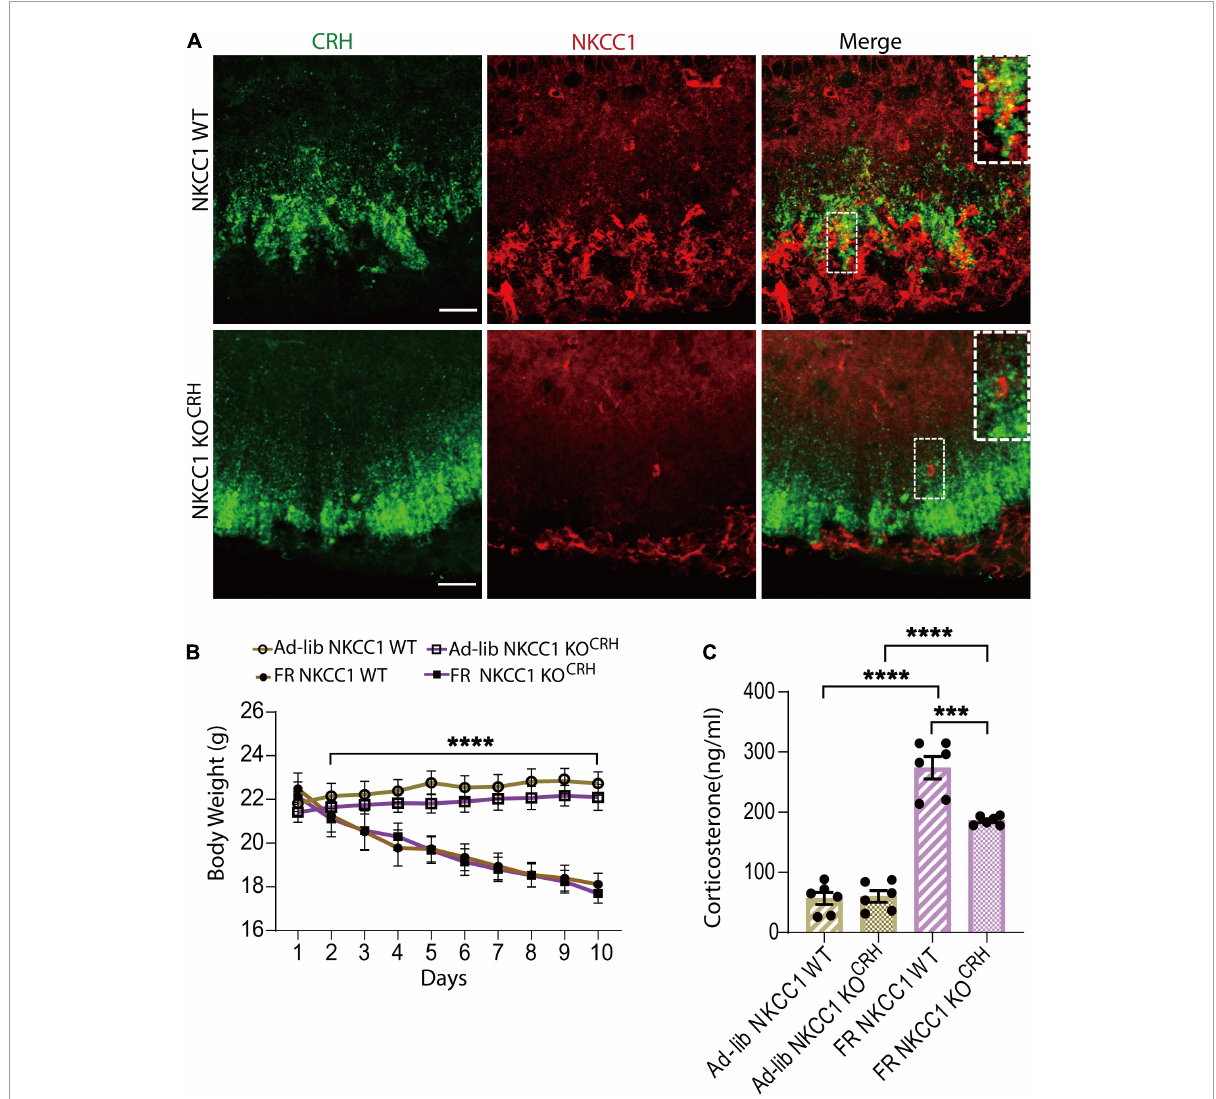
FIGURE5 Conditional deletion of NKCC1 from corticotropin-releasing hormone (CRH) neuronal terminals reduced the elevation of serum corticosterone in response to food restriction. (A) Immunohistochemical staining with anti-CRH (green) and anti-NKCC1 (red) antibodies in CRH neuronal terminals in the median-eminence (ME). NKCC1 immunoreactivity was observed in the outer layer of the ME and colocalized with CRH (upper panel). In NKCC1 KO CRH mice, NKCC1 immunoreactivity was not observed in CRH neuronal terminals (lower panel). Square areas at upper right corner are enlarged image of dotted area. Scale bars, 40 µ m. (B) Temporal changes in body weight in ad libitum (Ad-lib) and food restriction (FR) conditions; **** P < 0.0001; two-way ANOVA with Tukey’s multiple comparison test. (C) Concentrations of serum corticosterone at 9:00–11:00 a.m. in Ad-lib and FR groups, indicating a significant reduction in FR-induced corticosterone increases in NKCC1 KO CRH compared with NKCC1 WT; **** P < 0.0001, *** P < 0.0003, two-way ANOVA with Bonferroni’s multiple comparison test. Error bars represents SEM.